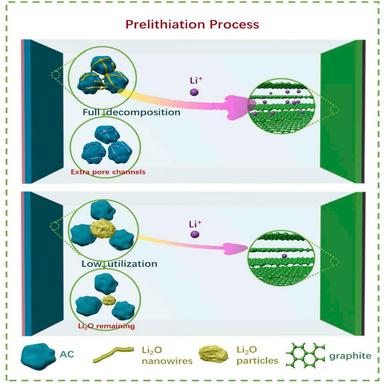
Schematic illustration of the prelithiation mechanism of prAC.